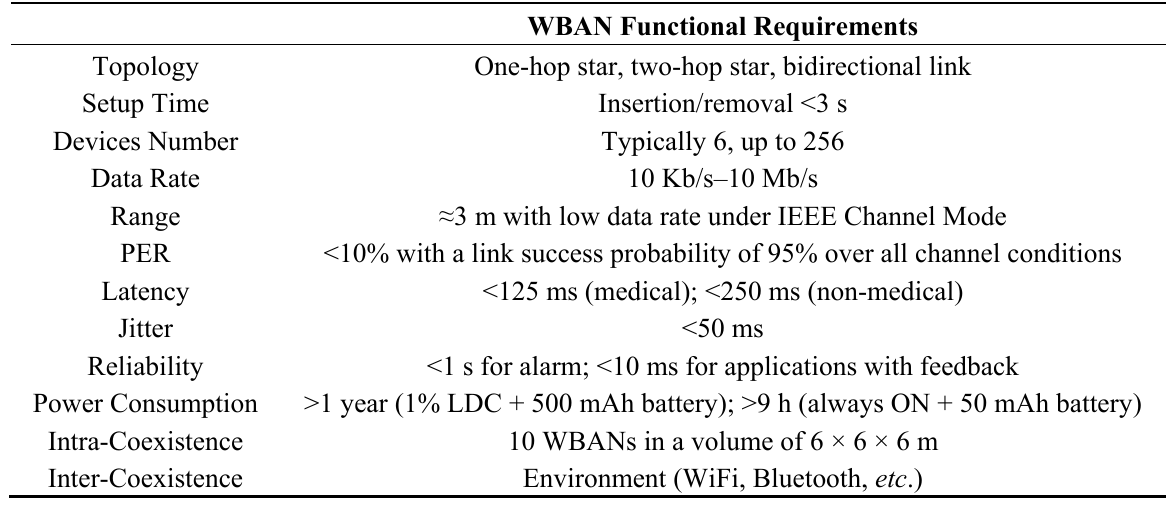
Table 1. IEEE 802.15.6 WBAN Requirements